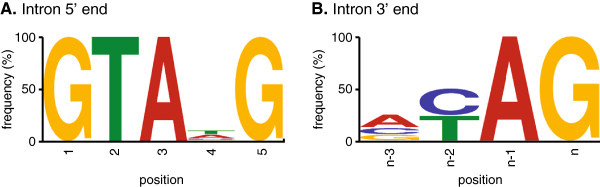
Derived consensus of intron splicing signals. The intron sequences common to the intron 5′ end (A) and the intron 3′ end (B) of Histoplasma genes. The vertical height of the nucleotide at each position indicates the relative nucleotide frequency (y-axis).